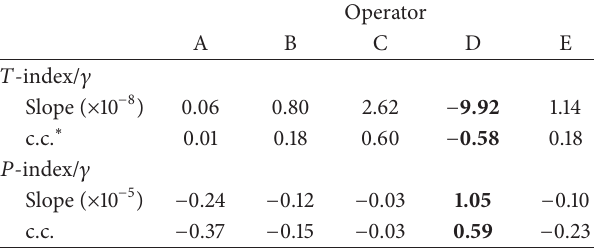
Table 6: Slopes of the regression lines and correlation coefficients in relation concerning Lyapunov